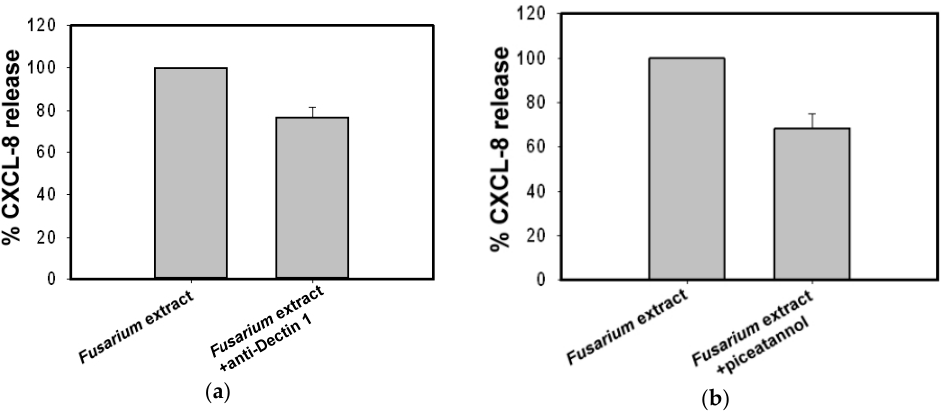
Figure 4. Effect of the anti-Dectin 1 and Syk specific inhibitor piceatannol on F. proliferatum stimulated CXCL-8 release. BEAS-2B cells were pre-incubated in the absence or presence of mouse monoclonal antibody against human Dectin-1 (2 µg/mL) ( a ) or Syk inhibitor piceatannol (5 µM) ( b ) for 1 h. Cells were then exposed to F. proliferatum extracts for 24 h and cultured supernatants were collected for CXCL-8 determination by ELISA. Results are representative of three independent experiments performed in duplicate.